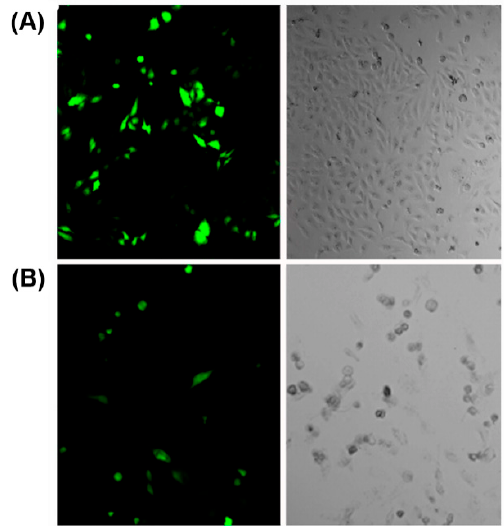
Figure 6. ( A ) Cells transfected with peptiplexes (N:P = 10.4) after 6 h of incubation in medium with reduced serum and 1.0 mM CaCl 2 . ( B ) Lipofectin transfected cells. Adapted from ref. [104]